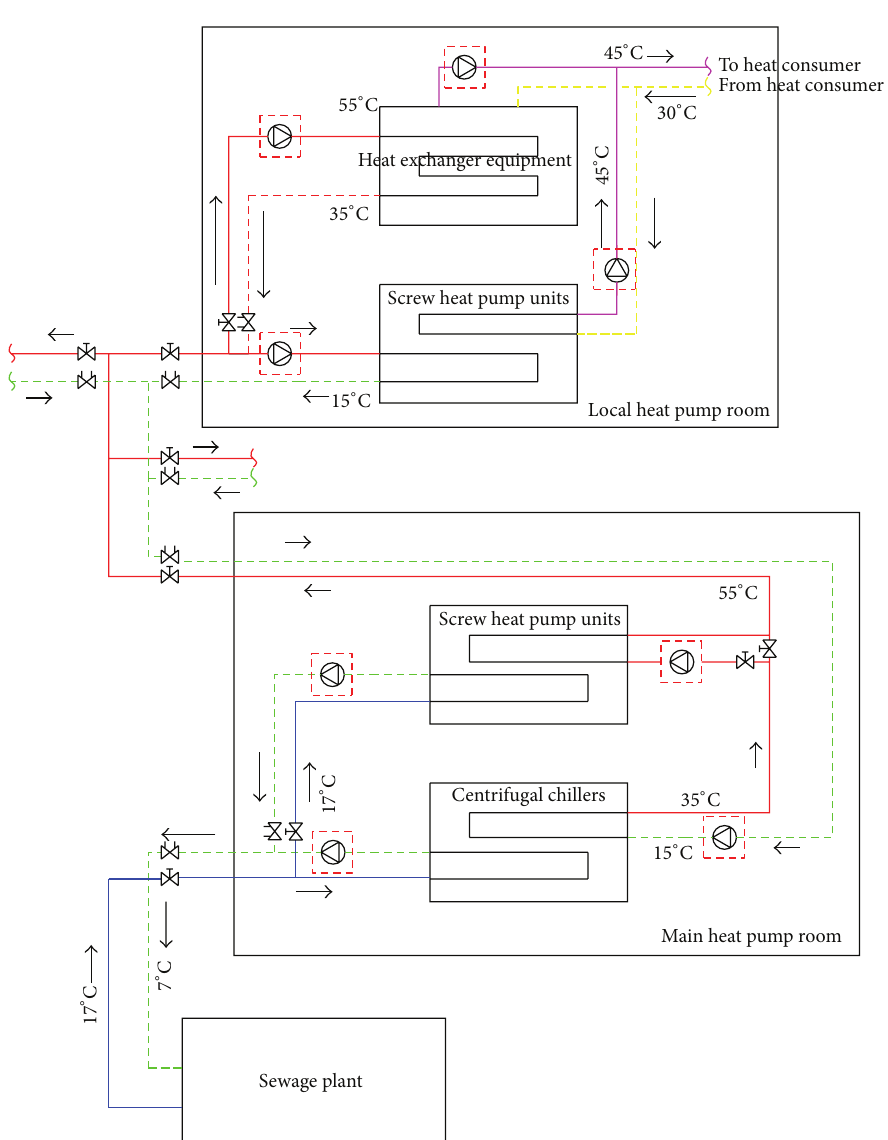
Figure 3: Schematic diagram of phase II project of heat pump